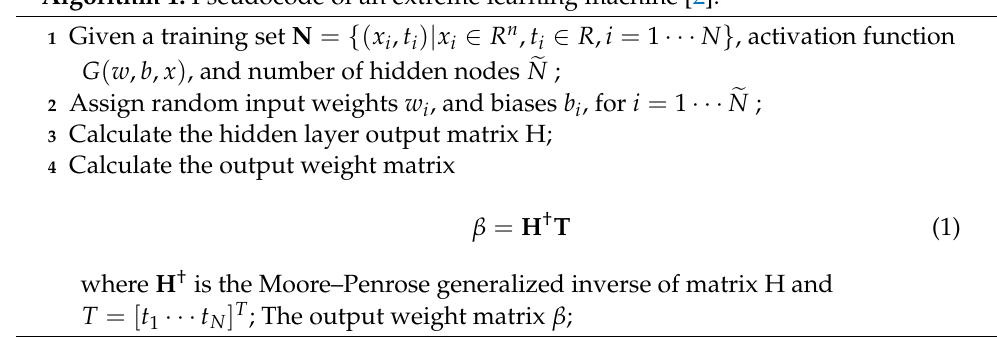
Algorithm 1: Pseudocode of an extreme learning machine